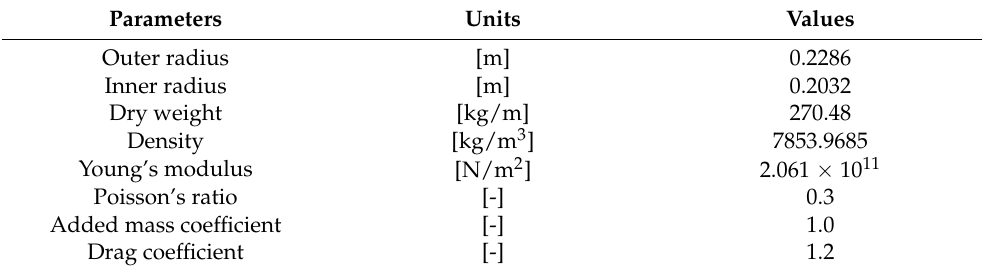
Figure 24. Riser analysis model: ( a ) schematic diagram of riser model [35], ( b ) riser dynamic model using the developed method. Table 1. Steel lazy wave riser properties [35].